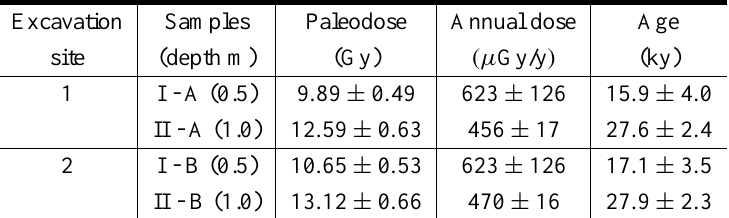
Sample names, paleodoses, annual doses and ages of sediments collected in the southern extremity of the Comprida island.